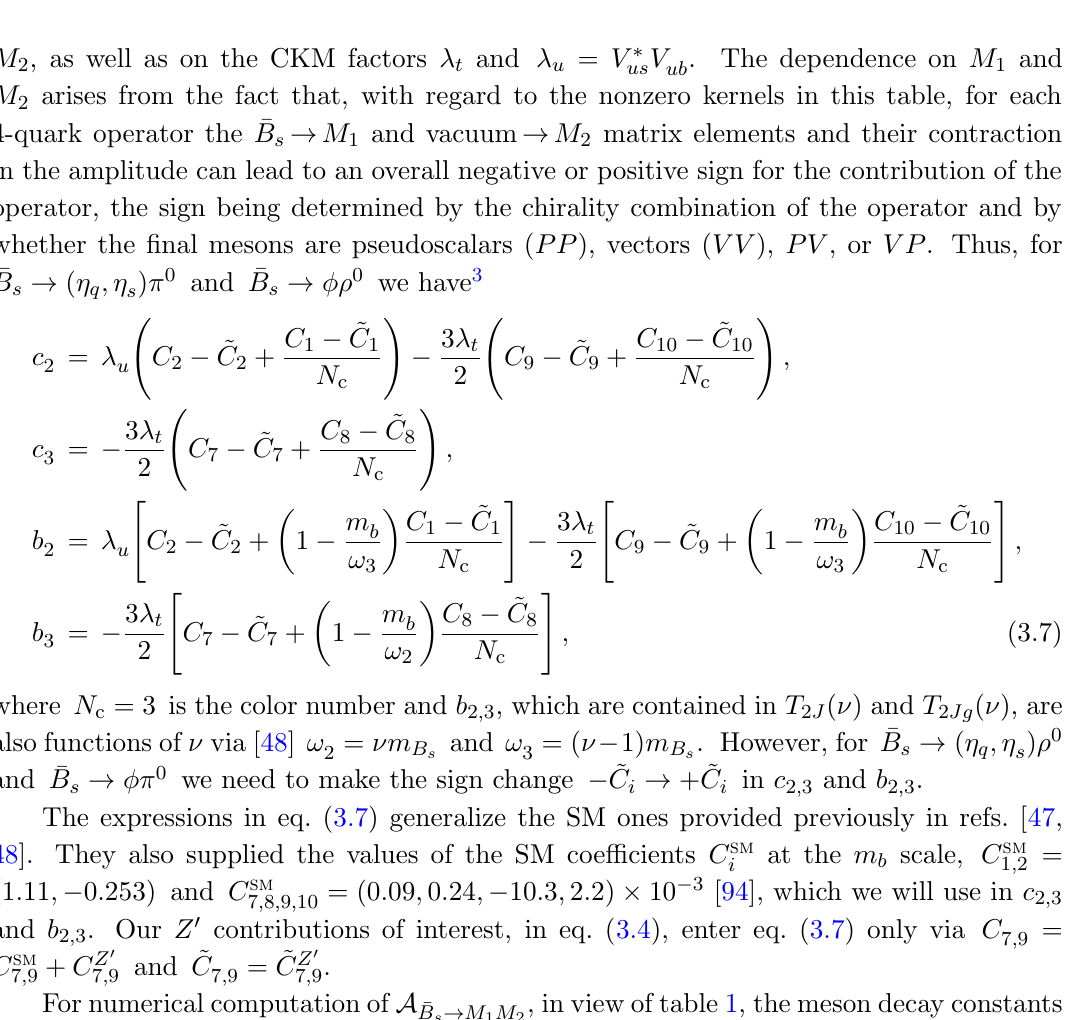
( (cid:23) ) for rJ;rJg ! b , where b k k k